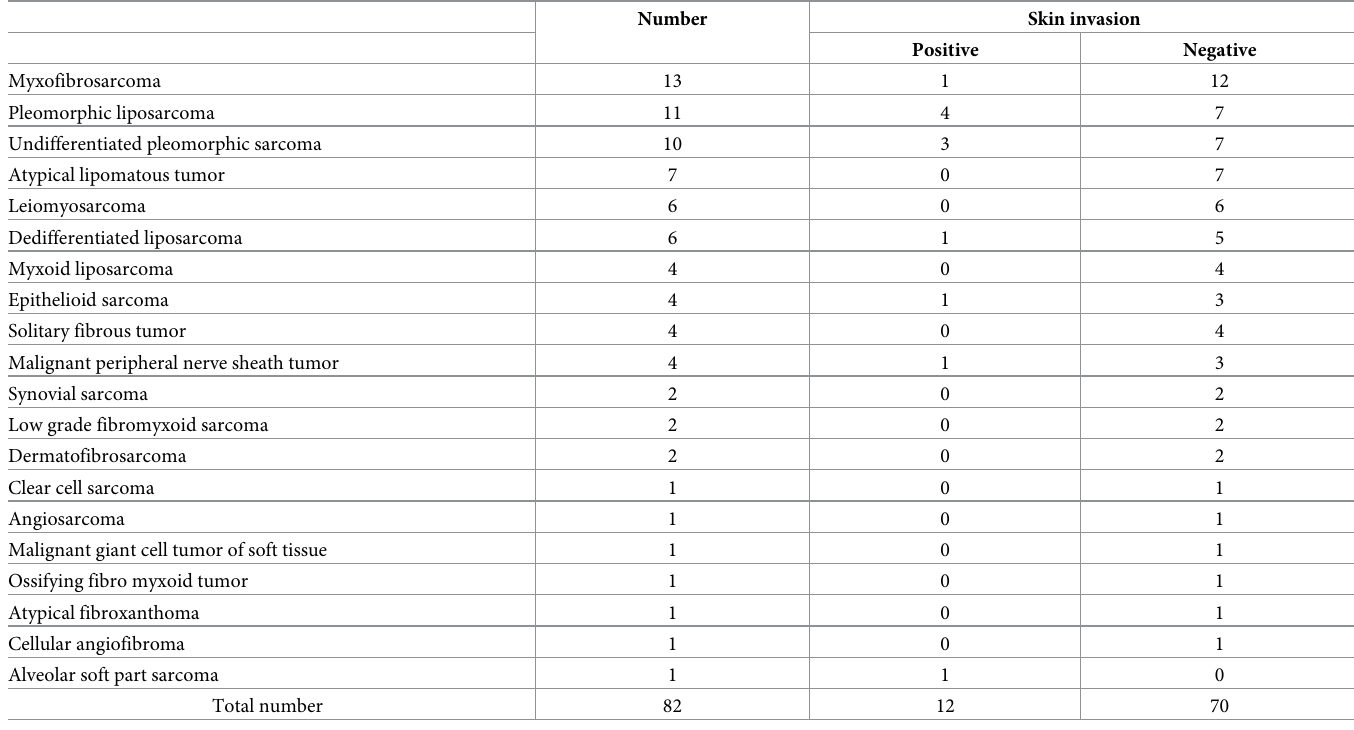
Table 2. Relationship of each histological classification with skin invasion